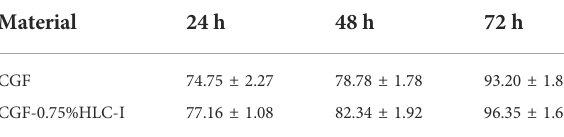
TABLE 3 The cytotoxicity of CGF membrane and CGF-0.75%HLC-I composite bio fi lm was determined by CCK-8 ( ‾ X ± S).